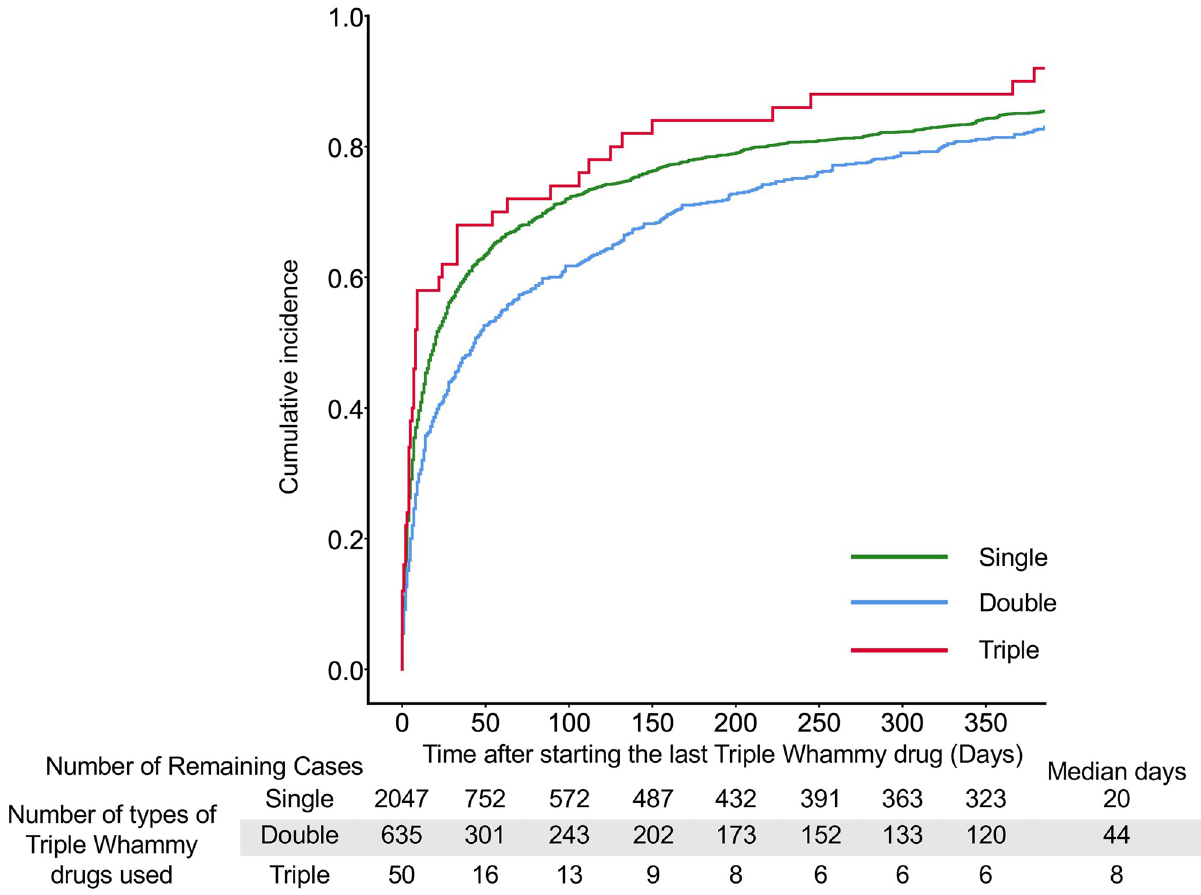
Fig 2. The cumulative incidence with the number of TW drug combinations. Median days indicate the date when the cumulative failure rate reached 50%.